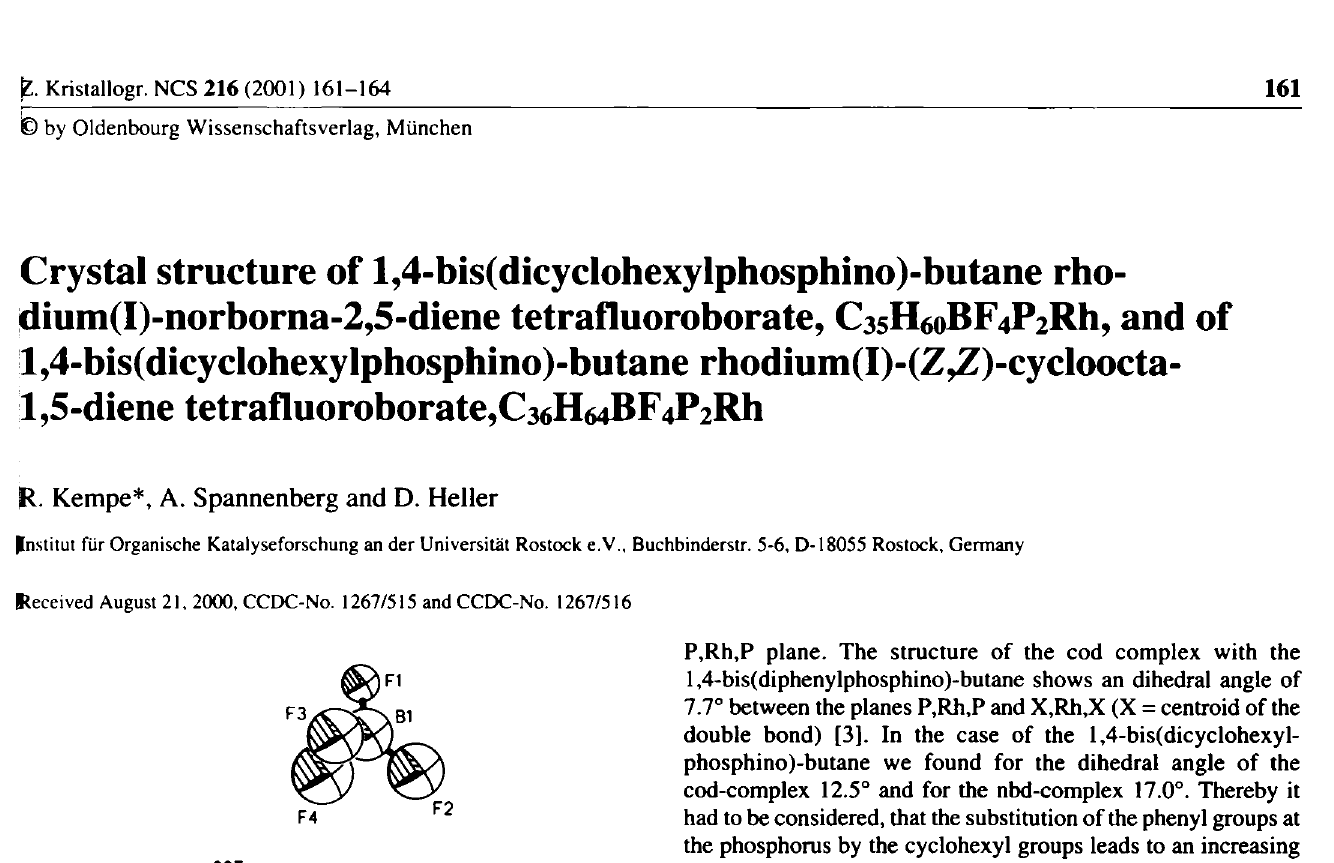
Table 2. Atomic coordinates and displacement parameters (in Ä 2